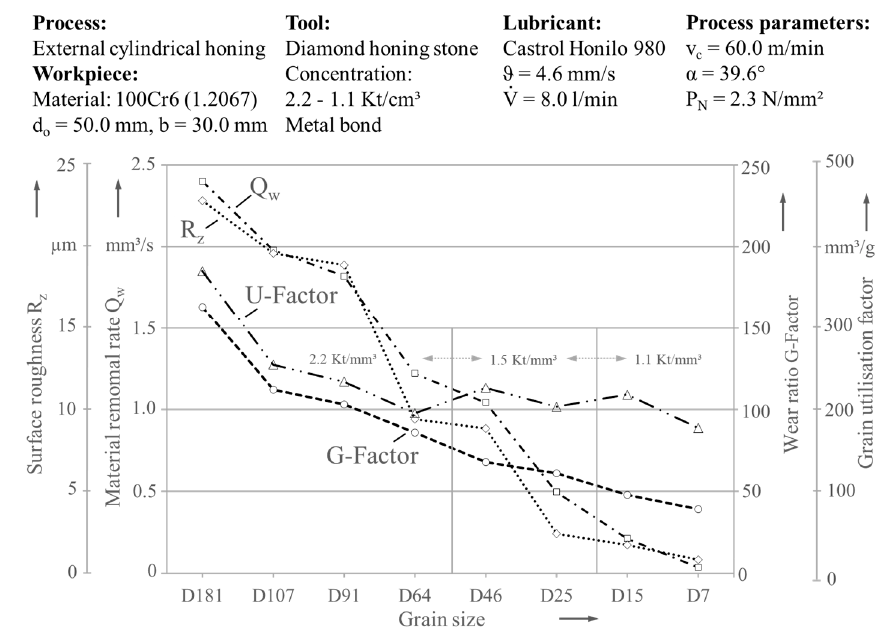
Figure 5. Cu tt ing performance and wear of diamond honing stones. Figure 5. Cutting performance and wear of diamond honing stones.